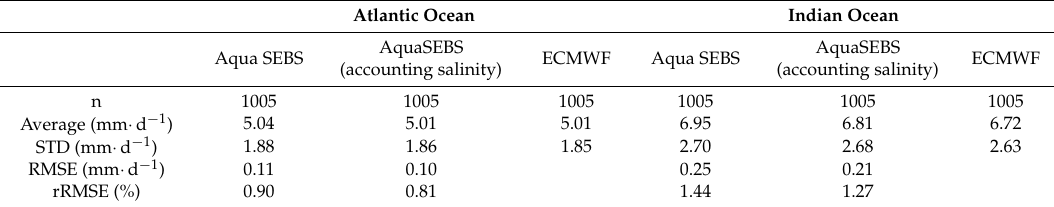
Table 5. Comparison between the evaporation rate values calculated by the AquaSEBS and ECMWF models (January 2010 to September 2012).